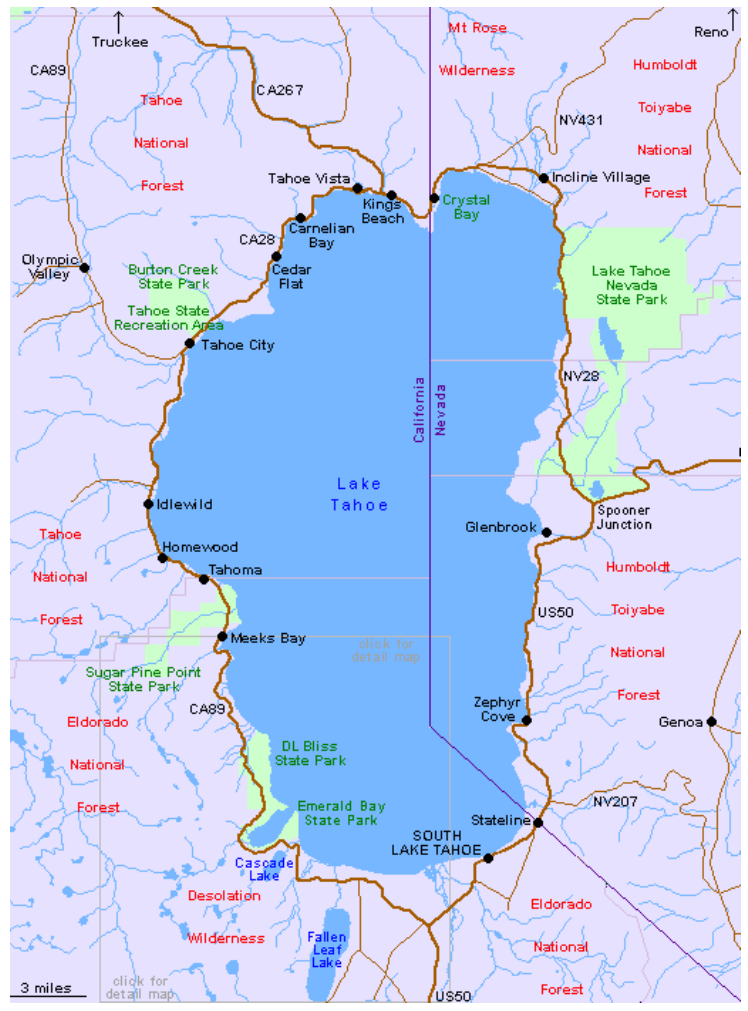
Figure 3. Lake Tahoe basin map (http://www.americansouthwest.net).